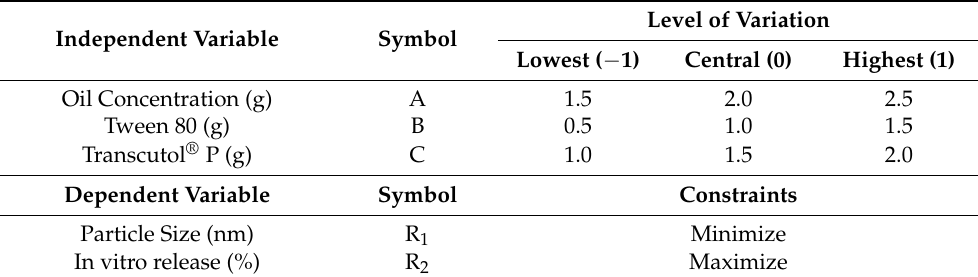
Table 9. BBD data presenting the independent variables with their levels of variation and the examined dependent